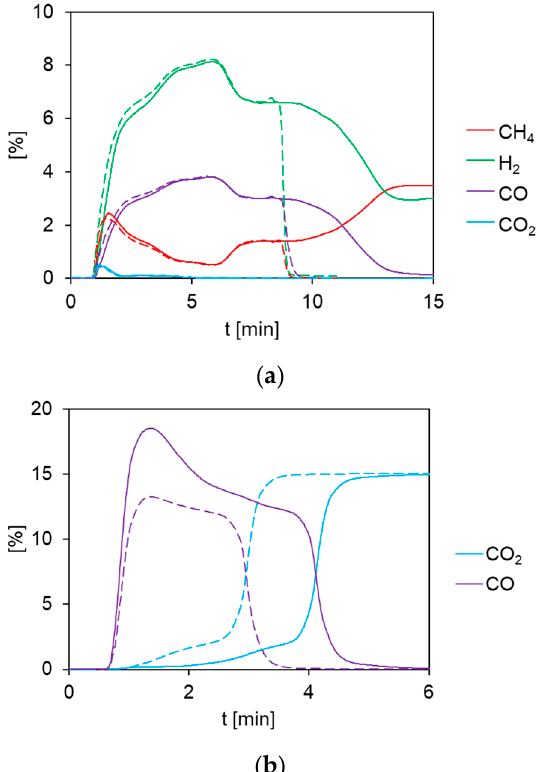
Figure 9. Isothermal cycles at 900 °C: reduction step ( a ), oxidation step ( b ), 2nd cycle (dashed line), 4th cycle (continuous line). 4th cycle (continuous